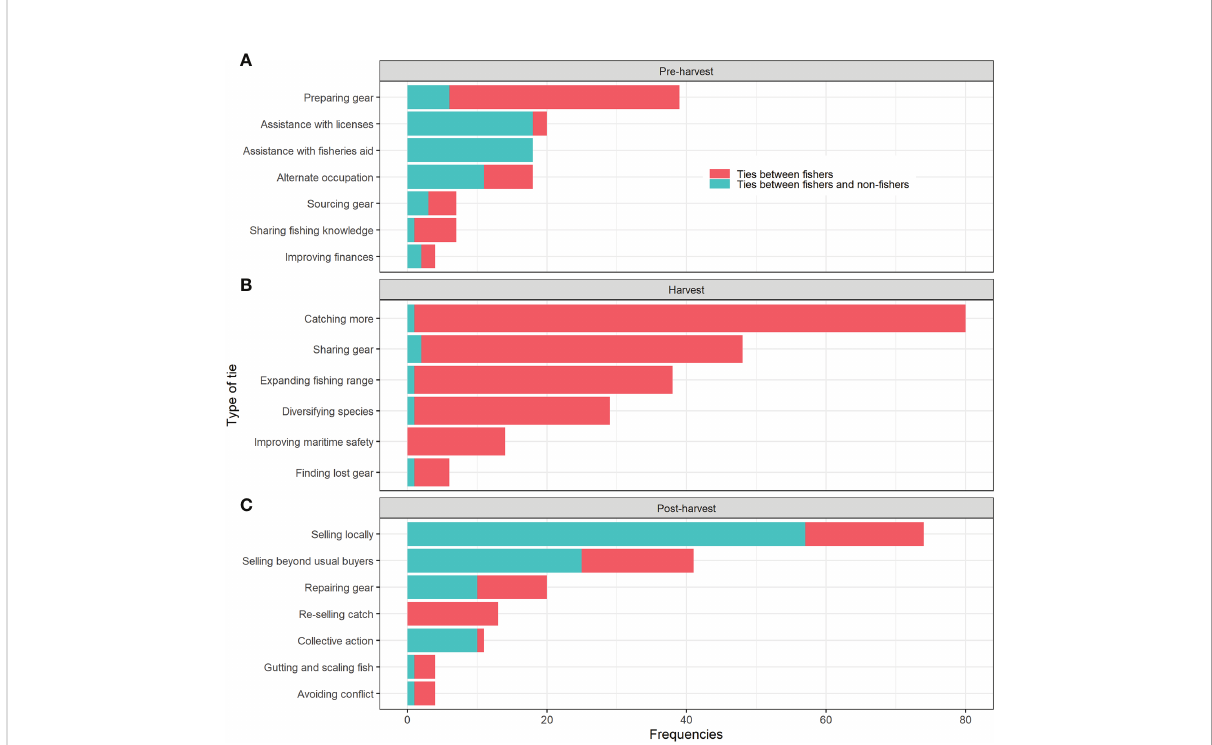
FIGURE 3 Frequencies of cooperative ties in the network of work support received by commercial fi shers, grouped by supply chain phases. Frequencies are colored according to whether the provider was a fellow fi sher (red) or if the support was given by other actors in the supply chain (blue), such as buyers, mechanics, and NGOs. Of these ties, 12 edge types emerged from responses. That is, they fi t the a-priori classi fi cation of “ other ” in the survey but were grouped through interpretation guided by the semi-structured interviews. De fi nitions for these categories are provided in Supp. Table 6. (A) Cooperative ties related to pre-harvest activities. (B) Cooperative ties related to harvesting activities. (C) Cooperative ties related to post-harvest activities. Supply chain phases were de fi ned according to reasonings by Basurto et al., 2020, who posit that access to capital (i.e., social, fi nancial, cultural), physical means of production (i.e., gear, aid), and fi shing property rights (i.e., licenses) are part of pre- harvest action situations, while collective action and con fl ict resolution mechanism are part of the post-harvest phase. Studies on Puerto Rico fi shing show how occupational multiplicity is a needed condition for many fi shers to operate (Grif fi th & Valde ́ s-Pizzini, 2002) and thus conceptualized as a necessary precursor for viable fi shing